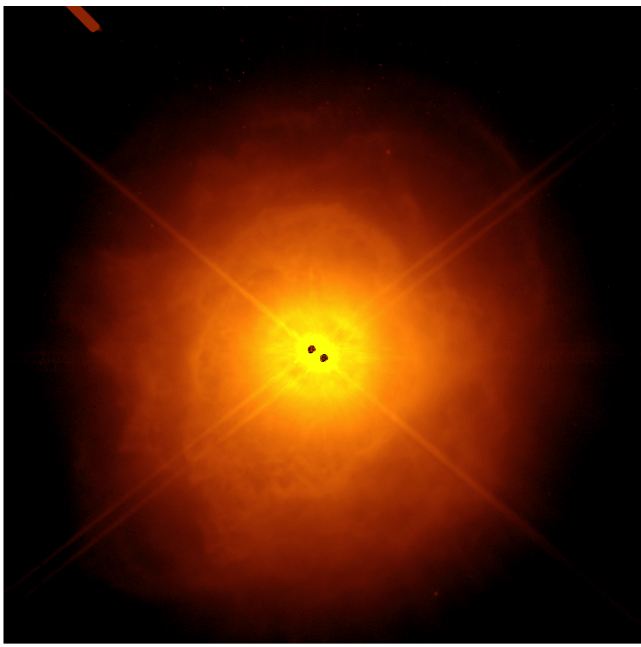
Figure 2. SPHERE/VLT observations of the post-RSG system AFGL4106 (Lagadec et al., in